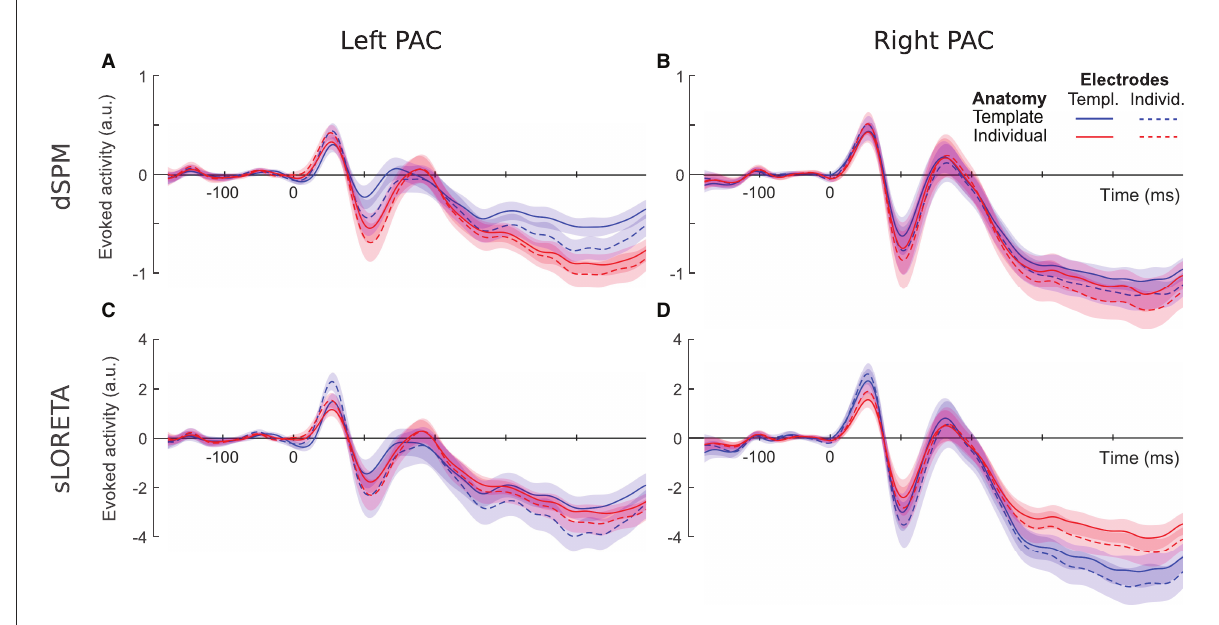
FIGURE2 Evoked PAC activity inferred via dSPM (top) and sLORETA (bottom) for the left (A,C) and right (B,D) PAC. Shaded areas denote the standard error of the mean (SEM)